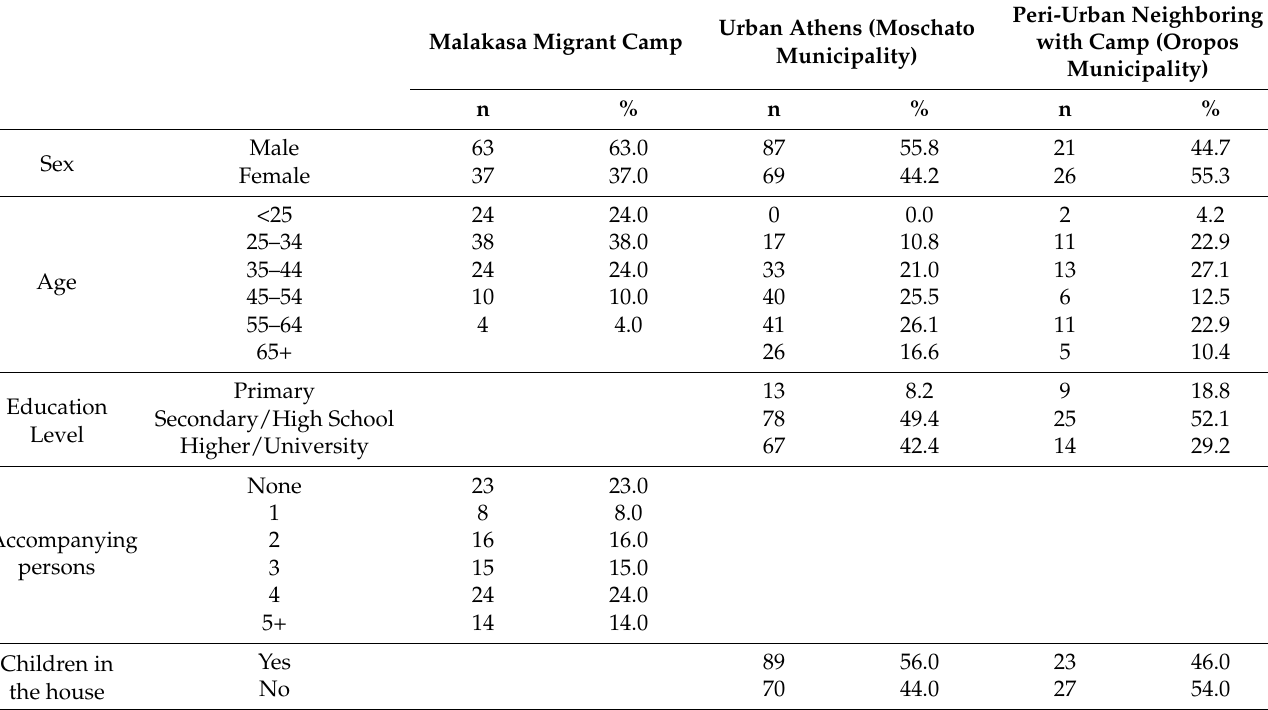
Table 1. Sample characteristics in the three survey